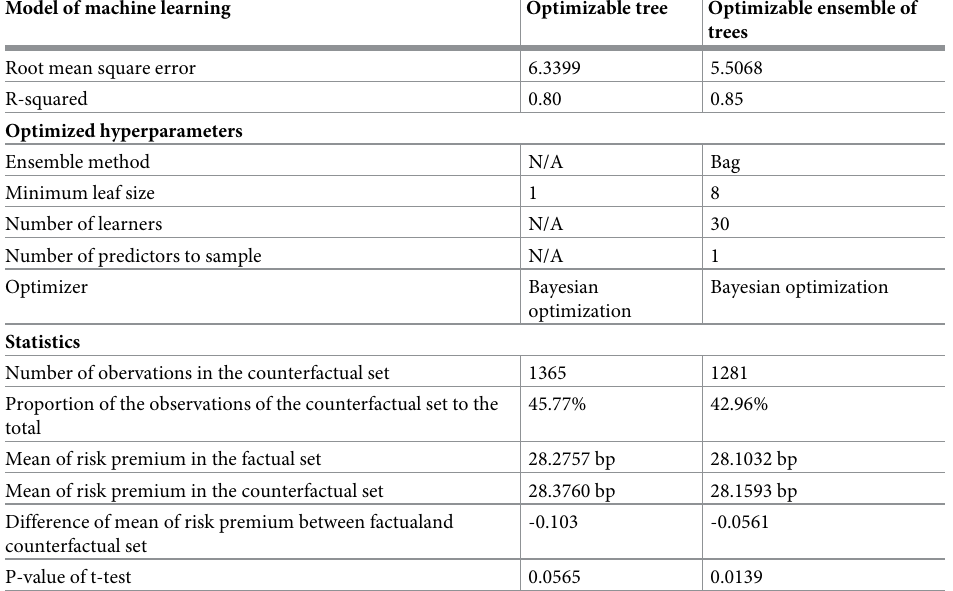
Table 13. The validation of endogeneity based on the machine learning model. This table reports the optimized hyperparameters of the two machine learning models (optimizable tree model and optimizable ensemble of trees model) and the statistics of counterfactual sets constructed by these two models. The last row reports the p-value of the t-test on the differences in risk premiums in the factual and counterfactual